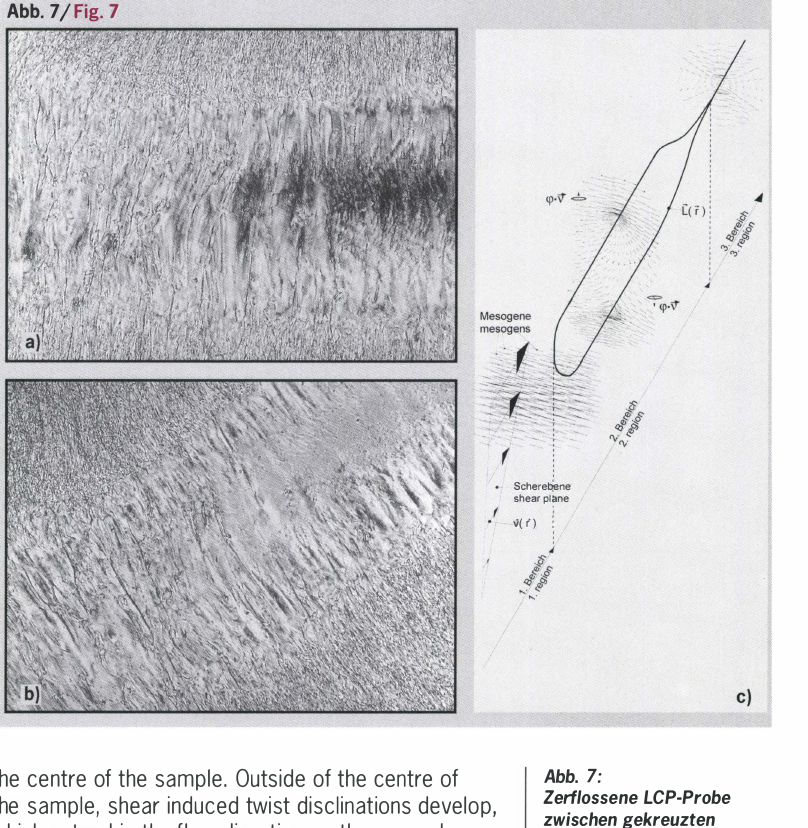
the centre of the sample. Outside of the centre of the sample, shear induced twist disclinations develop, which extend in the flow direction on the second region. After achieving a critical length of the disclination line, which corresponds to a critical shear strain and therewith a critical elastic stress, the lsi = 1/2-"integer" twist disclinations coalesce to disclinations with the higher strength lsi = 1 . Accordingly the third region includes the densely distributed shorter and less contrasted loops up to the sample border.